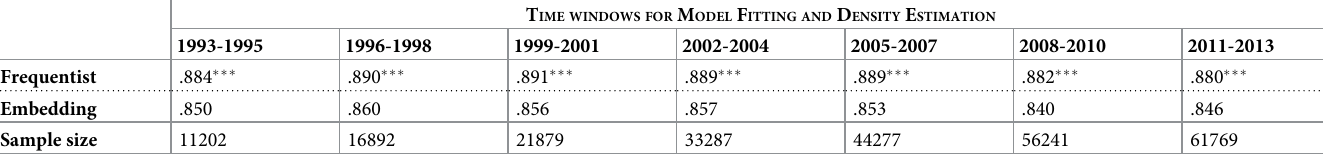
Table 3. Average AUROC for scientists 0 ! A transition, second setup. Average AUROC of the predicted 0 ! A transition for scientists. Time windows for both model fitting and density estimation are shown in the column headers ( Δ ϕ = Δ RCA = 2). Time windows for prediction testing begin immediately after the previous ones ( Δ test = 2). Entities that did not transition during the time window were not included in the